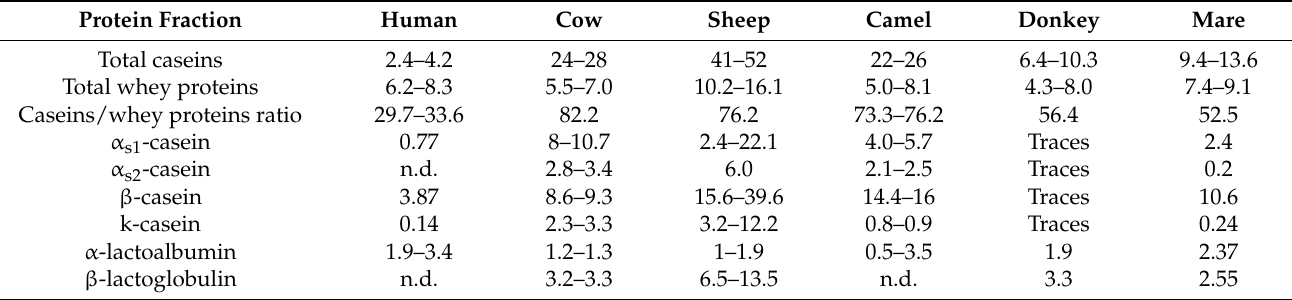
Table 4. Protein profile (g/L) of milk from different mammalian species.